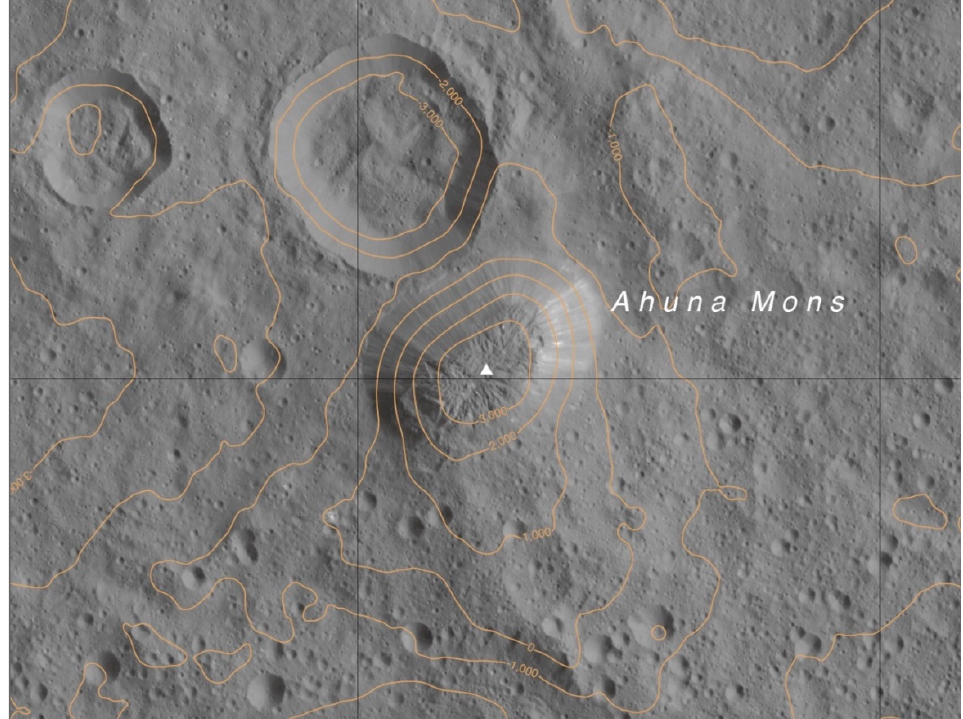
Figure 2. Altitude map of Ahuna Mons and surrounding area on Ceres, including Crater B next to it. Image credit: NASA/Ceres LAMO atlas. Ac-L-42-Ahuna Reprinted/adapted with permission from [9,10]. Scale